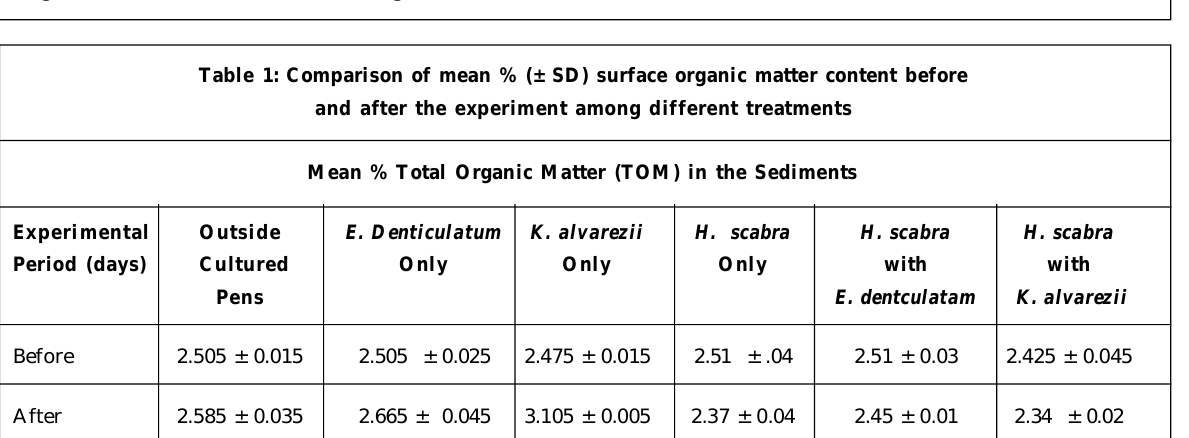
Figure 5: Mean (± SD) final wet weight of K. alvarezii co-culture with H. scabra and without H. scabra